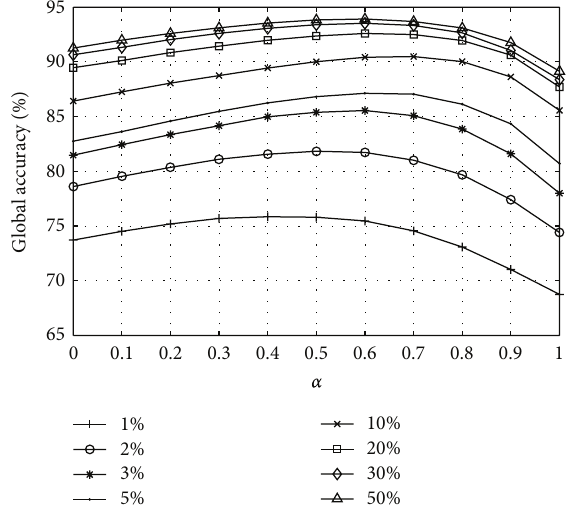
Figure 5: Effect of the DAS late fusion approach on the final performance, for various supervision levels. Plot of the accuracy as a function of the parameter 𝛼 that balances the fusion between SPH features (3 levels) if 𝛼 = 0 and CRFH if 𝛼 = 1 (IDOL2 dataset, random setup).